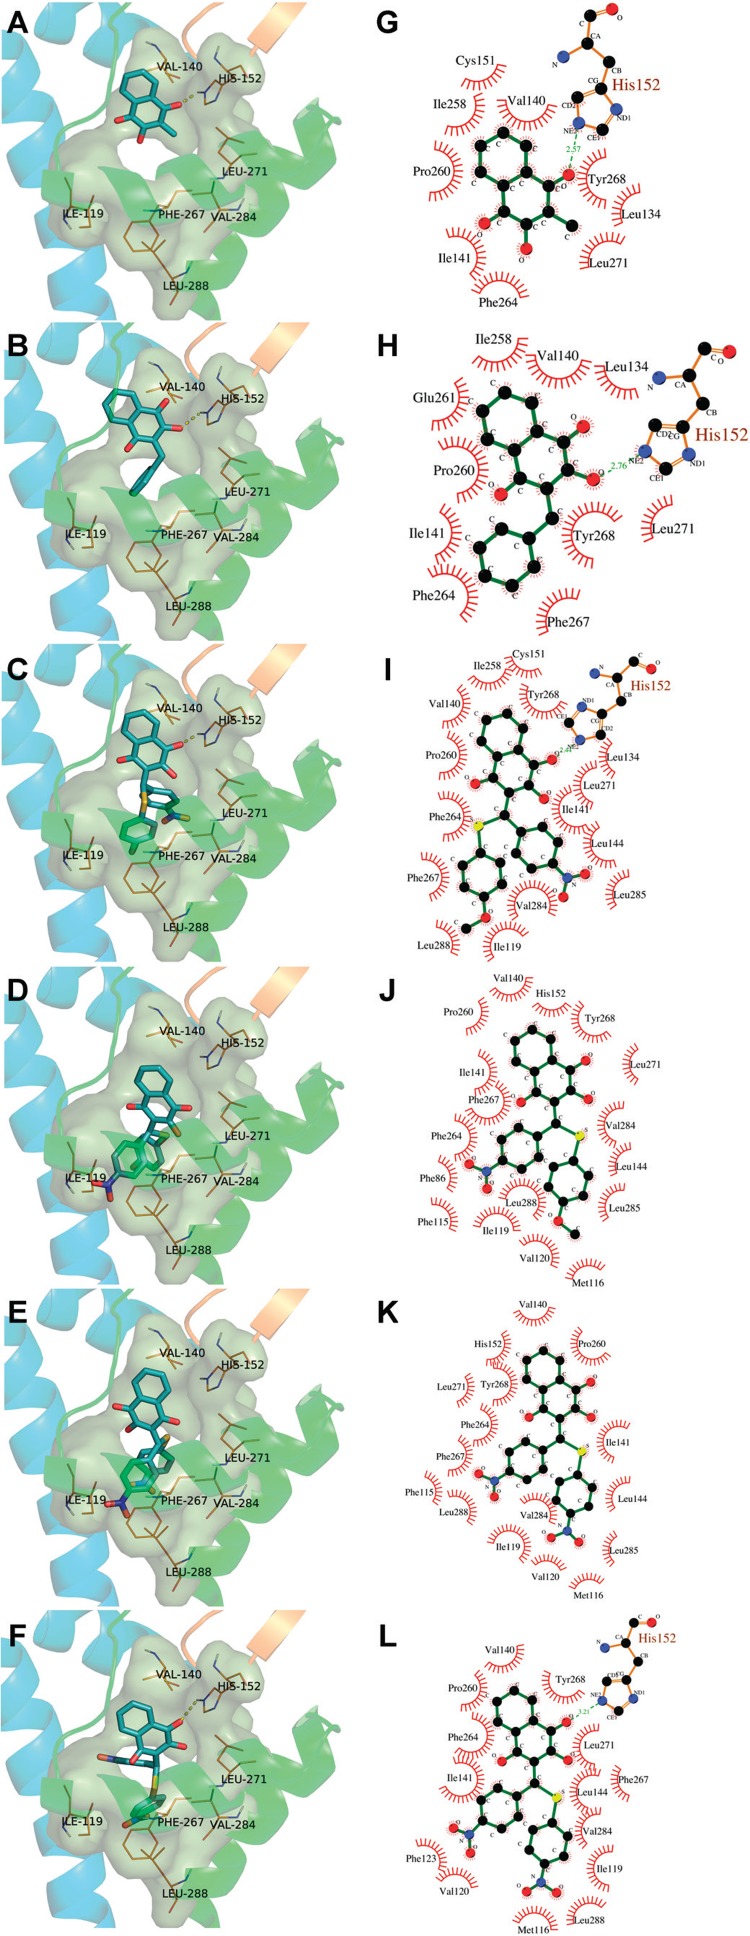
: proposed binding modes for the atovaquone analogues 1, 3, 33R, 33S, 37R, and 37S in the Qo site in Plasmodium falciparum bc1. Panels A-F show structural features of the binding site for compounds 1, 3, 33R, 33S, 37R, and 37S, respectively. Panels G-L show 2D representations of the main interactions between bc1 and compounds 1, 3, 33R, 33S, 37R, and 37S, respectively, as calculated by LigPlot+ (Laskowski & Swindells 2011). Ligands atoms numbers were omitted to aid visual inspection.